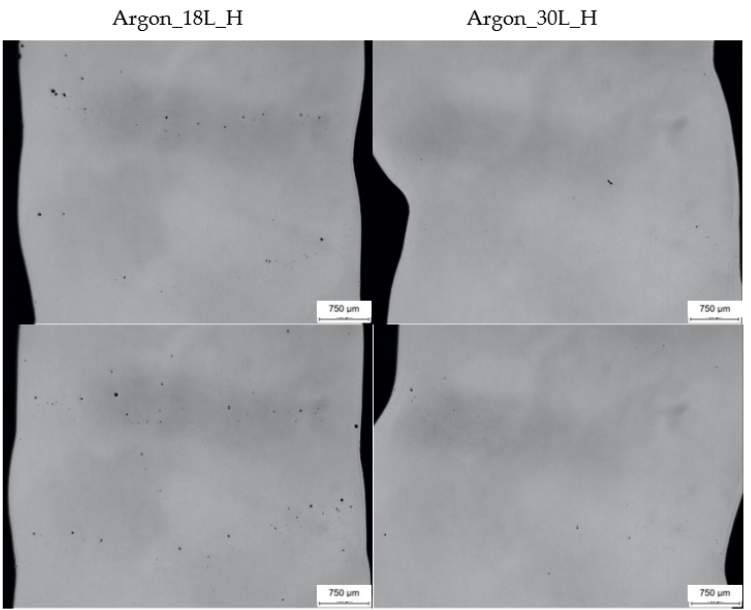
Figure 11. Aligned porosity with low shielding gas protection (18 L/min) and good protection (30 L/min).